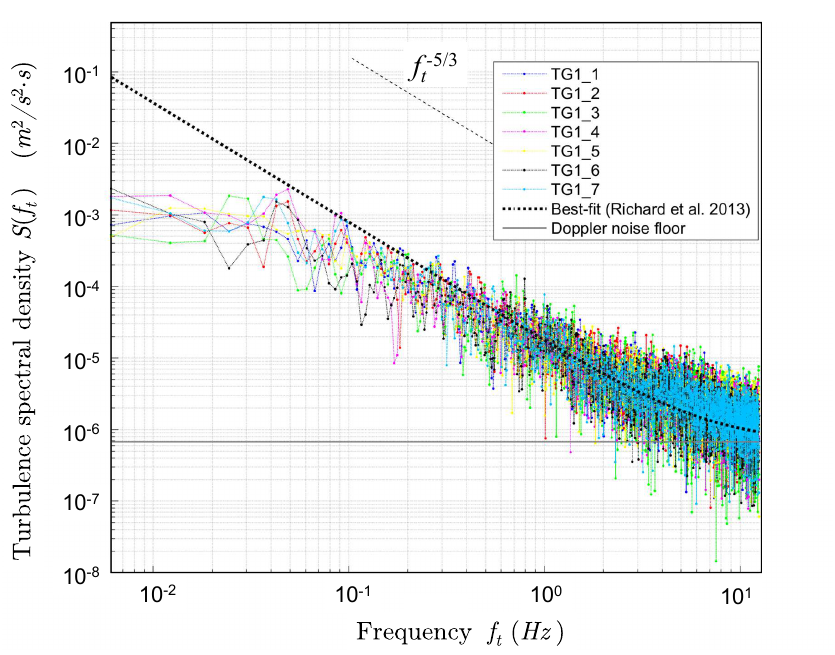
Figure 7. Measured current turbulent energy spectra